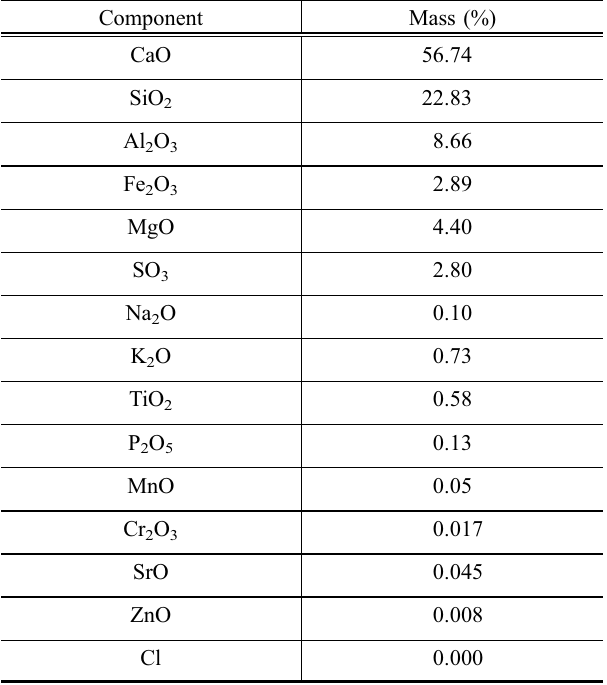
Table 1 Composition of componentsofcement samples.